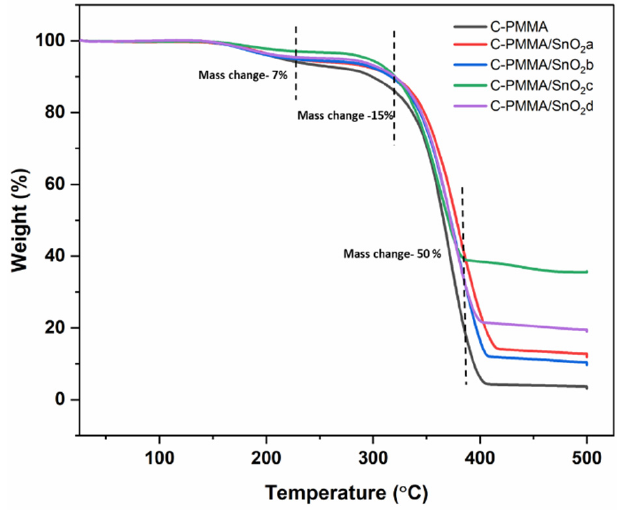
Figure 4. TGA of C-PMMA and C-PMMA/SnO 2 (a-d)